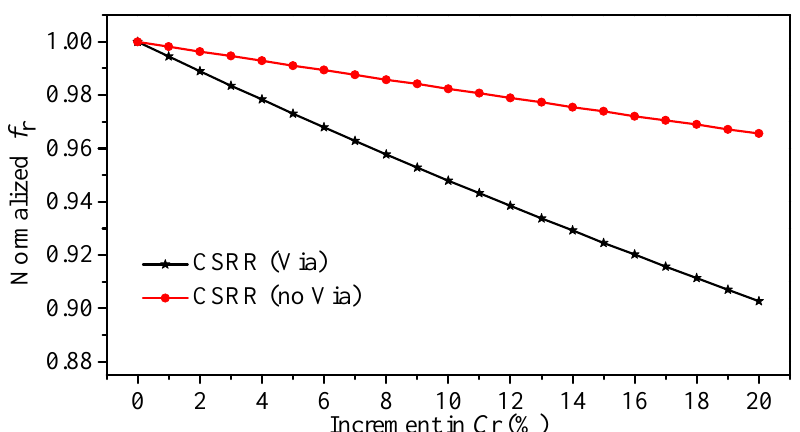
Figure 6. The normalized resonance frequency extracted from the circuit models versus the increment in C r (in percentage) for the original CSRR and the proposed